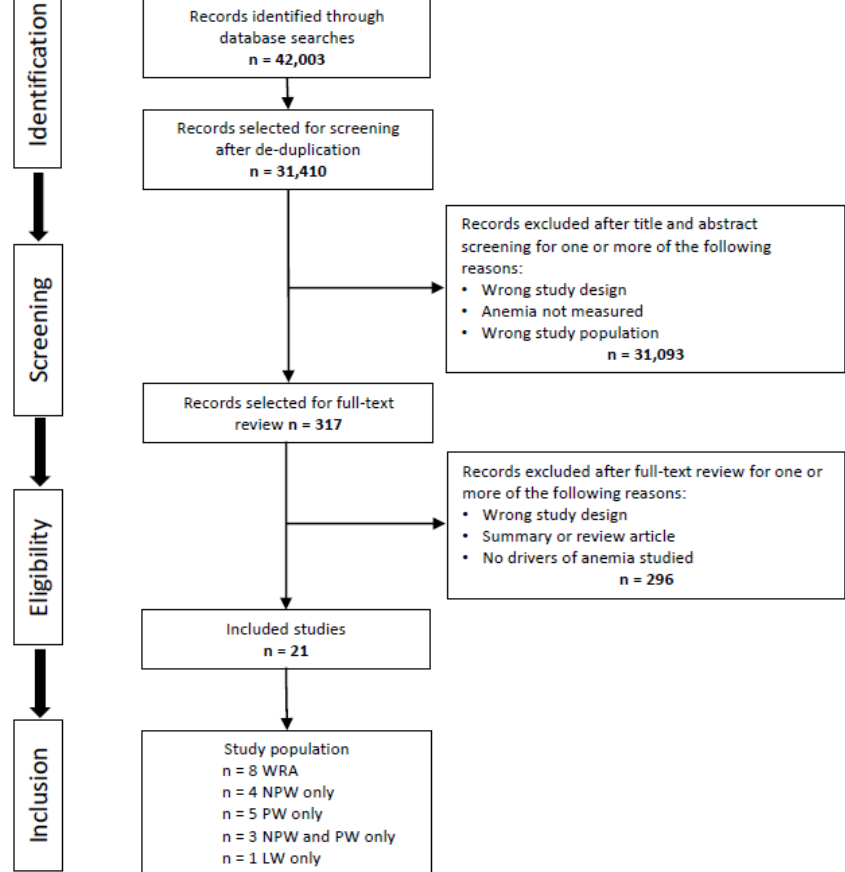
Figure 1. Flow diagram of the literature review process. WRA: women of reproductive age; NPW: non-pregnant women; PW: = pregnant women; LW: lactating women.